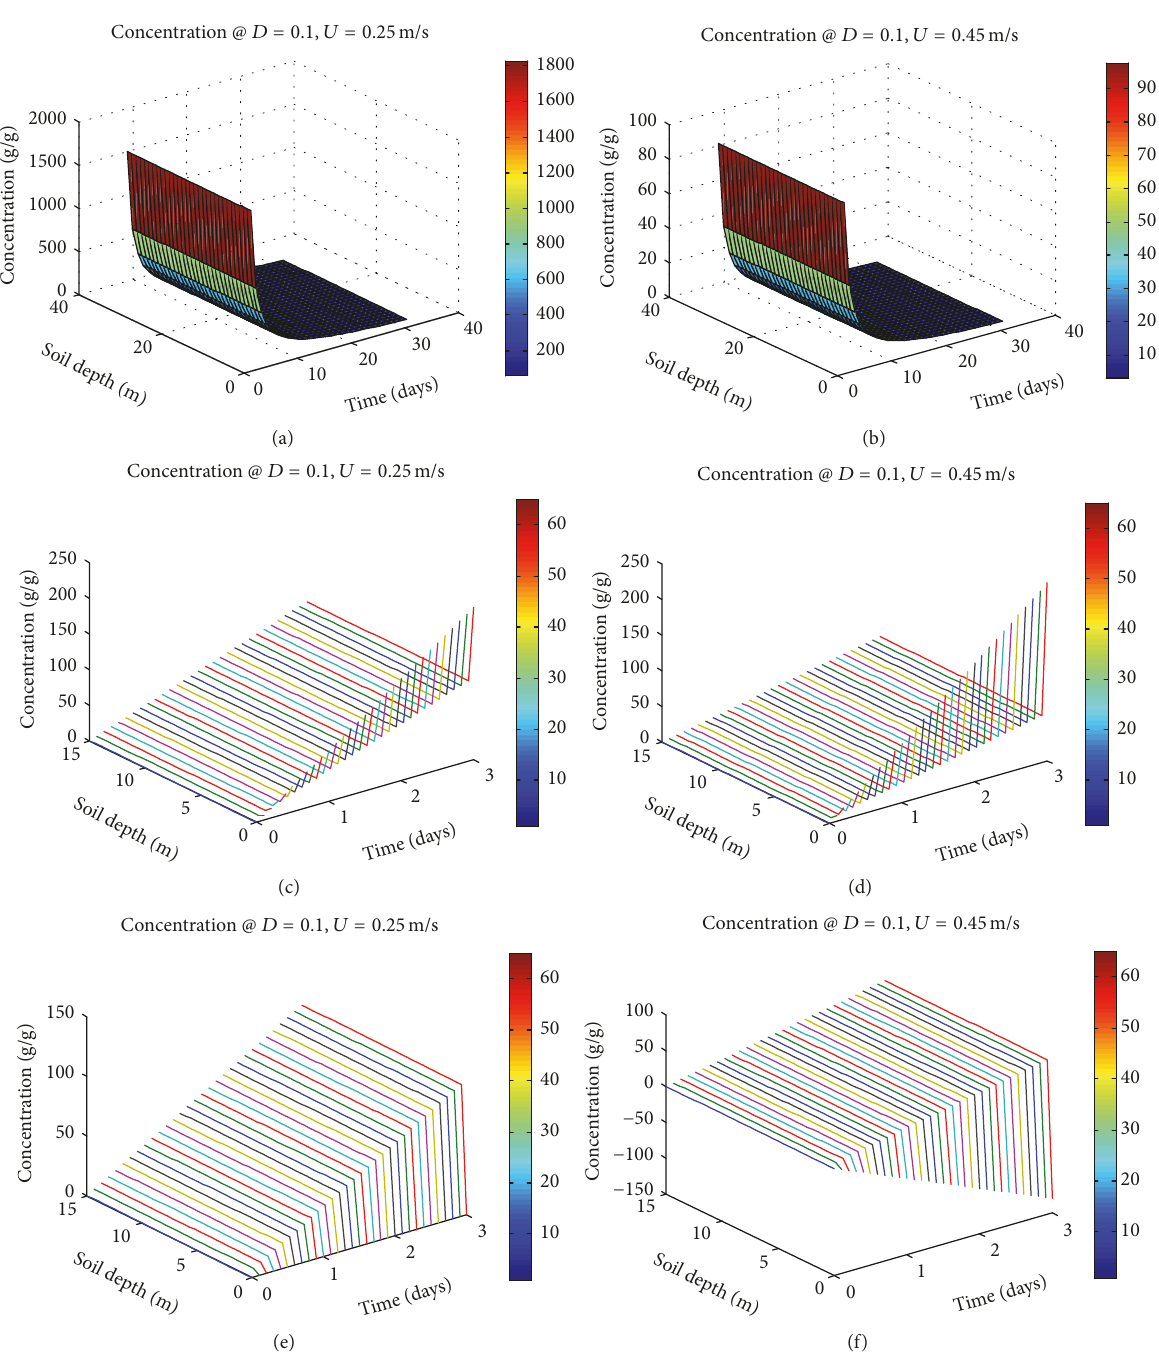
Figure 2: Possibilities of the bioremediation process: (a) Solution 1 at 𝐷 = 0.1 , 𝑈 = 0.25 ; (b) Solution 1 at 𝐷 = 0.1 , 𝑈 = 0.45 ; (c) Solution 2 at 𝐷 = 0.1 , 𝑈 = 0.25 ; (d) Solution 2 at 𝐷 = 0.1 , 𝑈 = 0.45 ; (e) Solution 3 at 𝐷 = 0.1 , 𝑈 = 0.25 ; (f) Solution 3 at 𝐷 = 0.1 , 𝑈 = 0.45